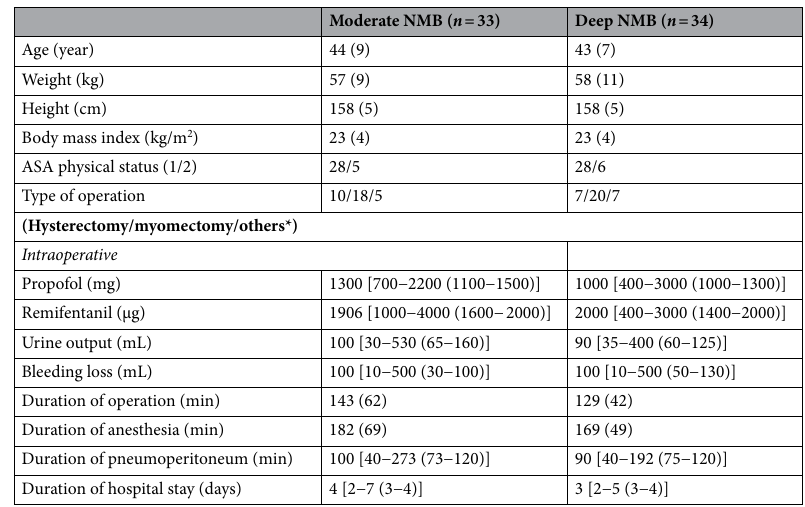
Table 1. Patients characteristics and operative details. Values are presented as mean (standard deviation), median [range (interquartile range)], and the number of patients. Abbreviations: NMB neuromuscular block, ASA American Society of Anesthesiologists, RBC red blood cell. *Includes staging, salpingo-oophorectomy, cystectomy, and uterovaginal